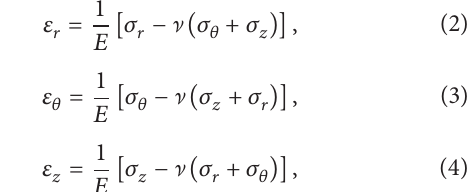
Figure 3: Displacement of a circumferential line element of the 𝑑̃ℓ ∗ 𝑑̃ℓ C of thecross-section, length 𝜃 tothat of 𝜃 . Thecentroidal circle having the radius 𝑟 before deformation, is also depicted by a dotted curve. Through the displacement described by ̃𝑢 and ̃ V , the line element is elongated slightly in the 𝜃 direction and the normal to the centroidal curve rotates with an angle 𝛽